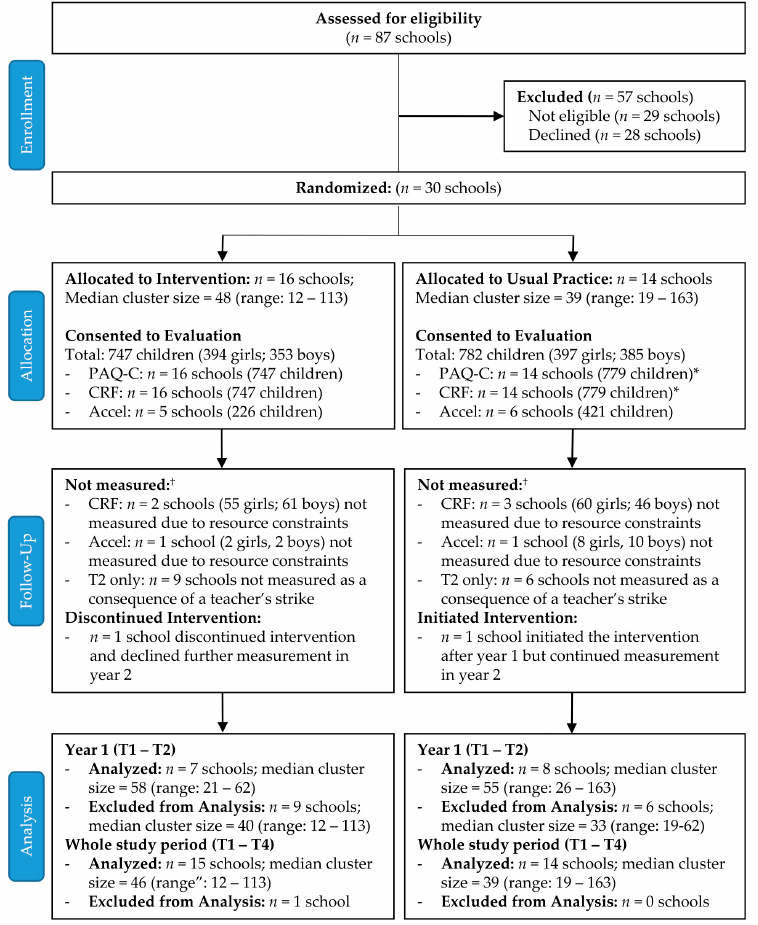
Figure 2. CONSORT diagram illustrating flow of schools through study. * 3 girls at UP schools consented to accelerometry only. † Details on follow-up and analysis at the student-level are described in text and tables for each outcome.